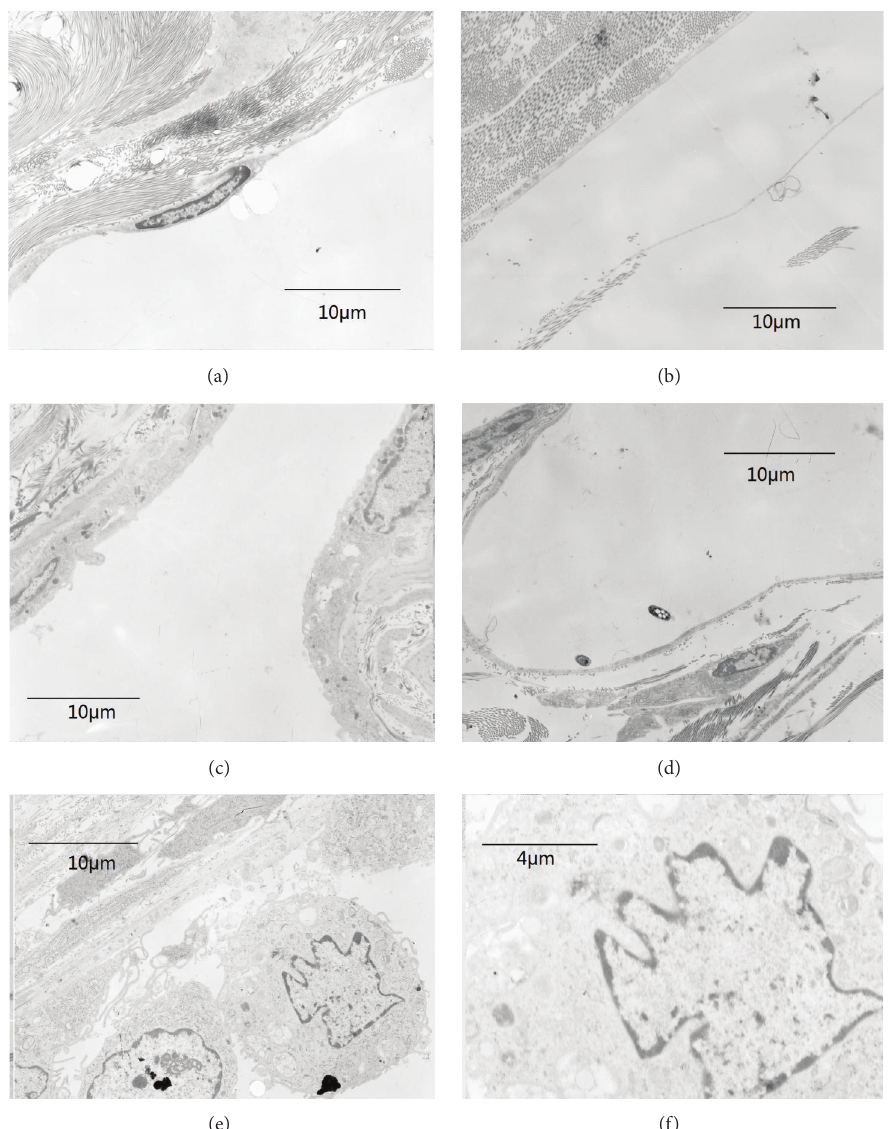
Figure 9: Transmission electron microscope. A weak fibrous capsule formation marked by arrows was observed around all of the 4 biomaterials: (a) control group, × 2500; (b) group 1, × 2500; (c) group 2, × 2500; (d) group 3, × 2500. And small amounts of macrophages marked by arrows had been observed nearby ((e) × 2500, (f) ×